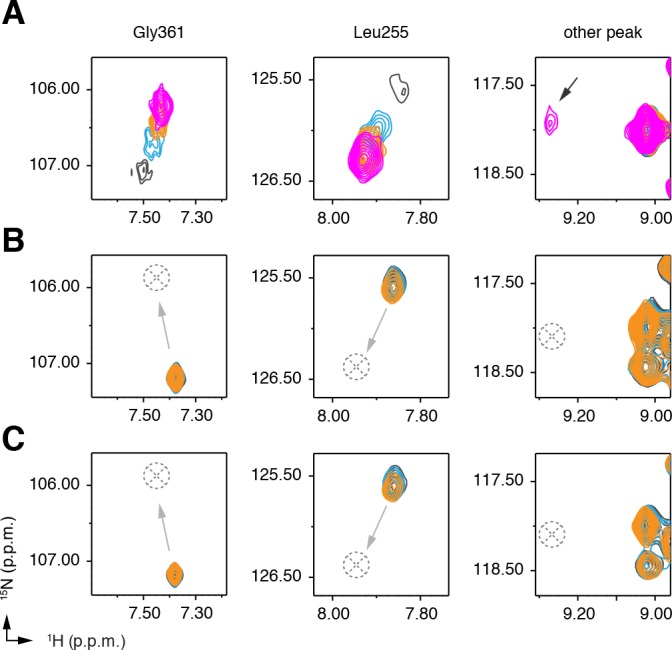
Differential 2D [1H,15N]-TROSY-HSQC NMR data showing that chemical shifts corresponding to residues (G361, L255, and an unassigned peak) perturbed when.(A) C9 (1, 2, and three equiv. ; blue, orange, and magenta, respectively) binds to native PPARγ (black), (B,C) but not when C9 (1 and 3 equiv.; blue and orange, respectively) binds to rosiglitazone-bound (two equiv.) PPARγ in the (B) delipidated or (C) native form. The black arrow denotes a peak present when PPARγ is bound to C9; grey arrows denote the lack of transition to a C9-bound peak, which is missing in the rosiglitazone-bound data (dotted circle/cross).